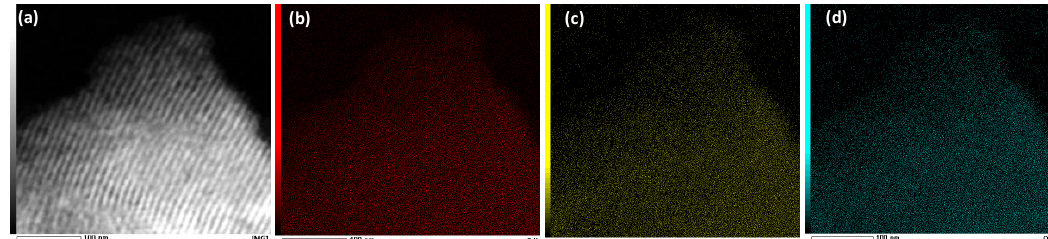
Figure 7. STEM image of a typical carbon ( a ) along with the EDX mapping showing the distribution of C ( b ), N ( c ) and O atoms ( d ) in the materials.